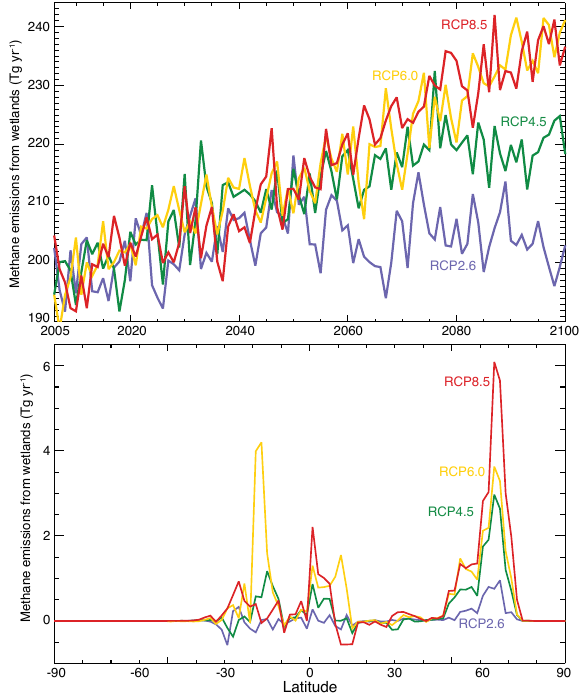
Fig. 21. Methane emissions from wetlands (Tg yr − 1 ) projected un- der the RCP scenarios (top; global total) and zonal mean change in methane emissions from wetlands between the 2090s and 2006– 2014 (Tg yr − 1 per 2 degree band;